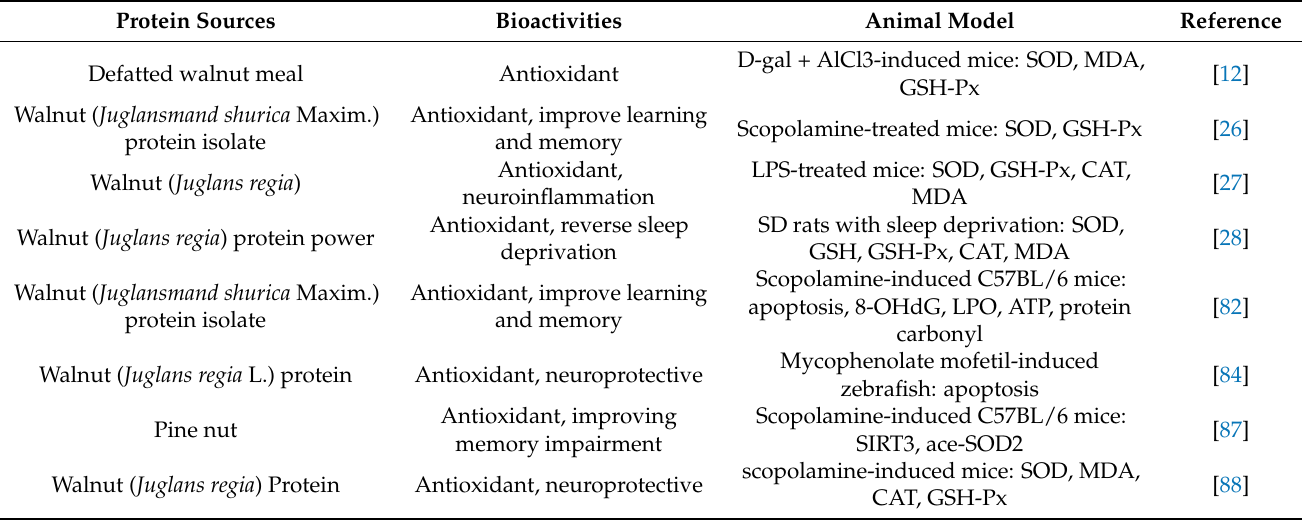
Table 5. Evaluation of antioxidant activity of nut-derived peptides by animal